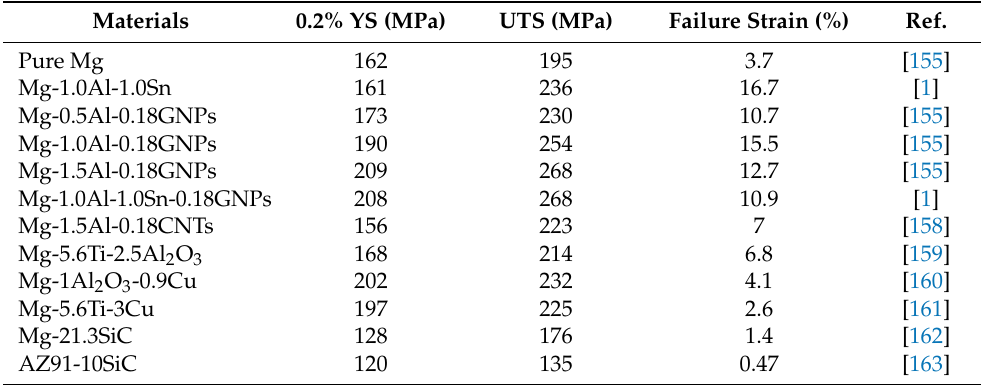
Table 5. Comparison of mechanical properties of Mg-based